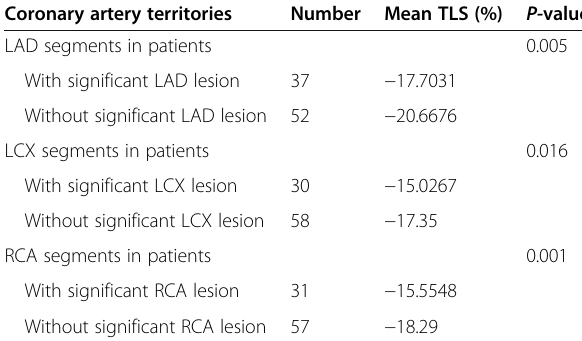
Table 5 Correlation of TLS and significant CAD in each coronary artery territory